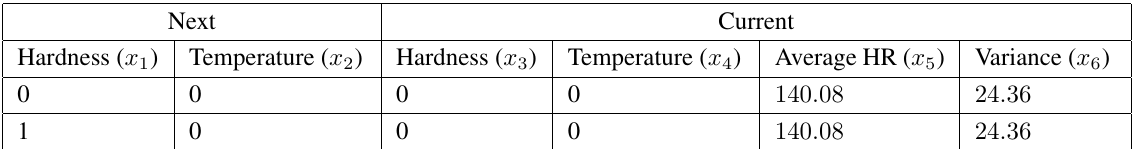
Table 3. Input data points for the next training